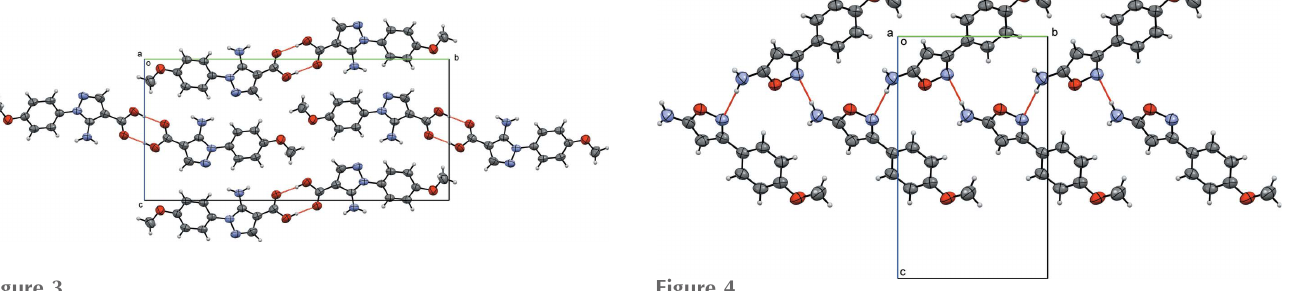
Figure 4 A view along the a -axis direction of the crystal packing of (II) with hydrogen bonds shown as red dashed